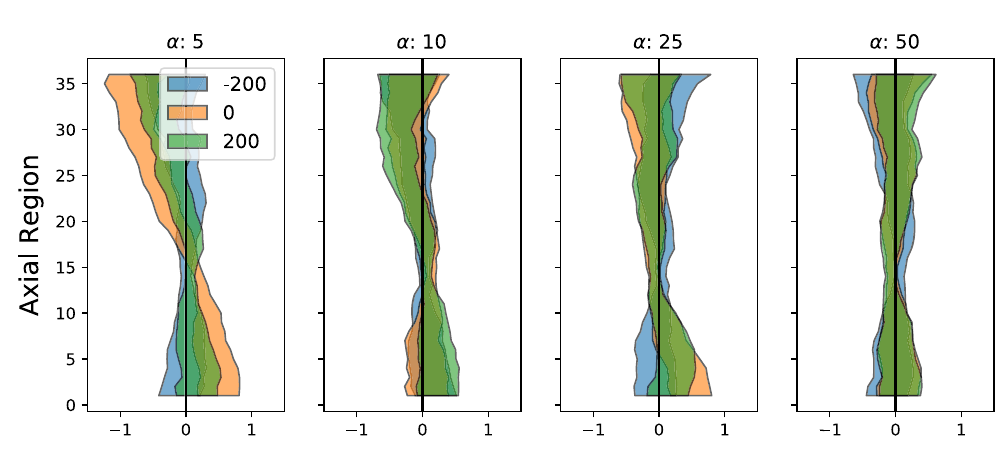
Figure 3: TF (power): Relative difference (%) with reference after final